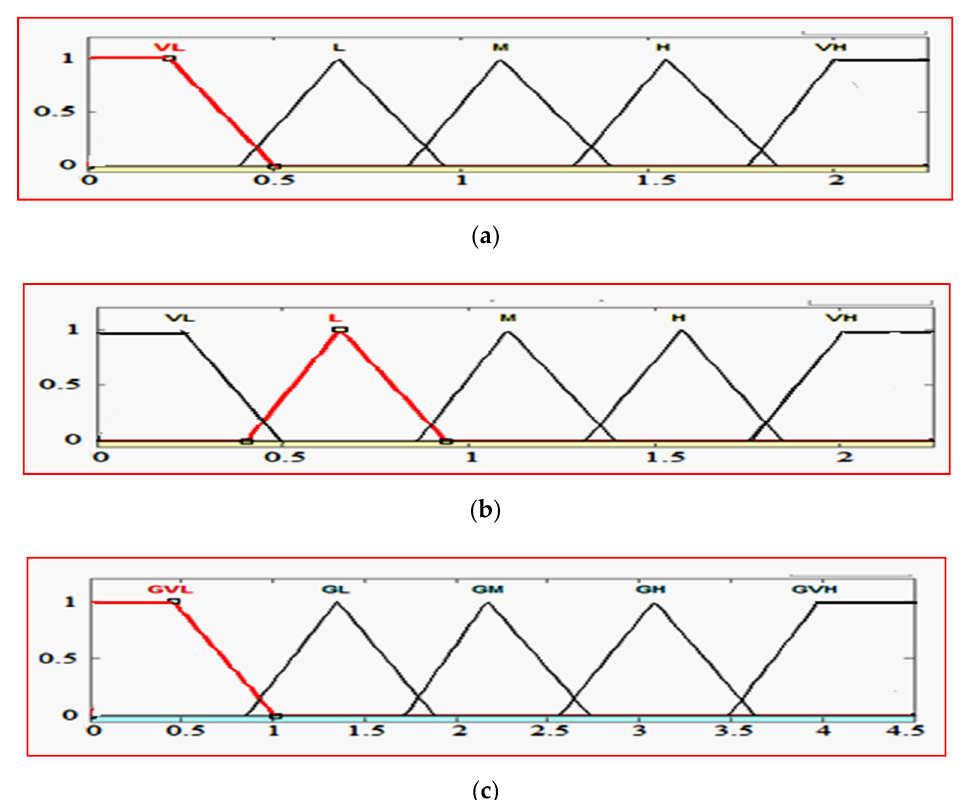
Figure 9. Grid power selection input and output fuzzy variables (fuzzification variable versus power in kW) ( a ) PV power (kW) ( b ) wind power (kW) ( c ) grid power (kW).